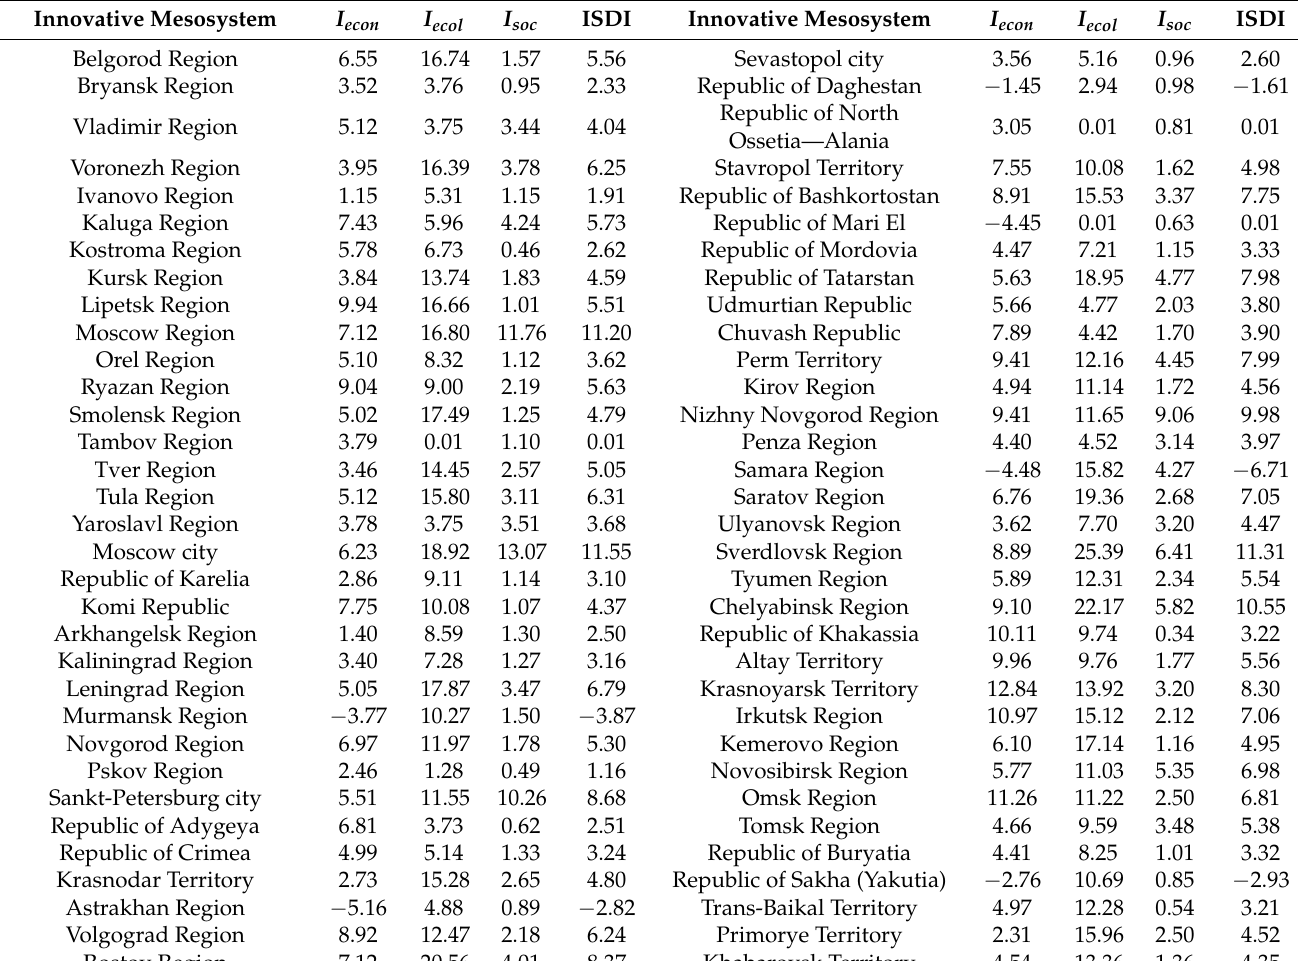
Table 1. Factors and integral indicator of innovative mesosystems sustainable development (calculated according to the author’s